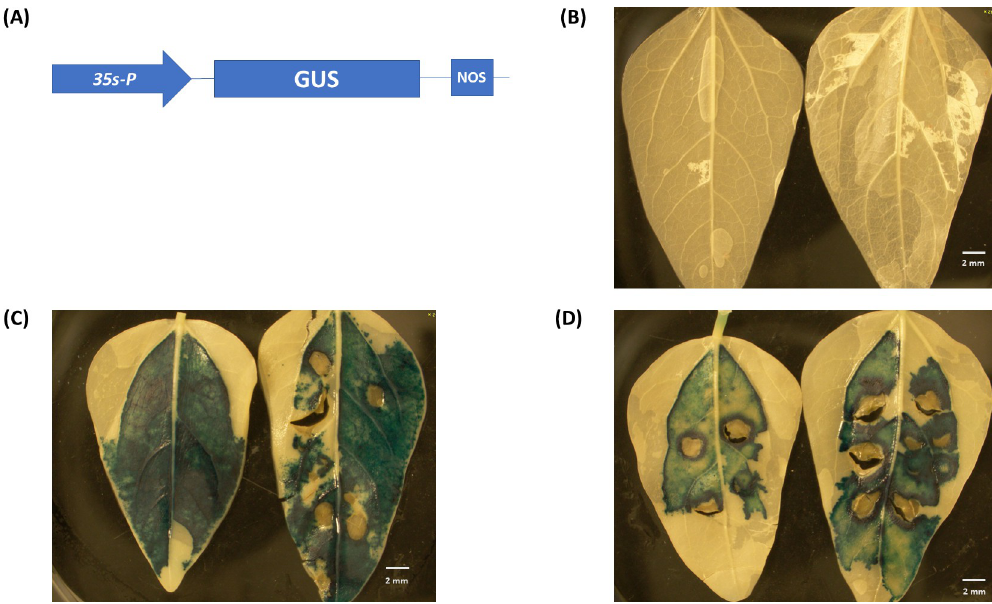
Fig 4. Transient GUS expression via agroinfiltration with 35S promoter :GUS construct in cowpea leaves. ( A) 35S promoter : GUS construct used in this study. (B) Control leaves (infiltration with Agrobacterium strain EHA105 without vector). (C) Cowpea leaves infiltration with Agrobacterium strain EHA105 containing 35S promoter :GUS vector. (D) Cowpea leaves infiltration with Agrobacterium strain AGL-1 containing 35S promoter :GUS vector.